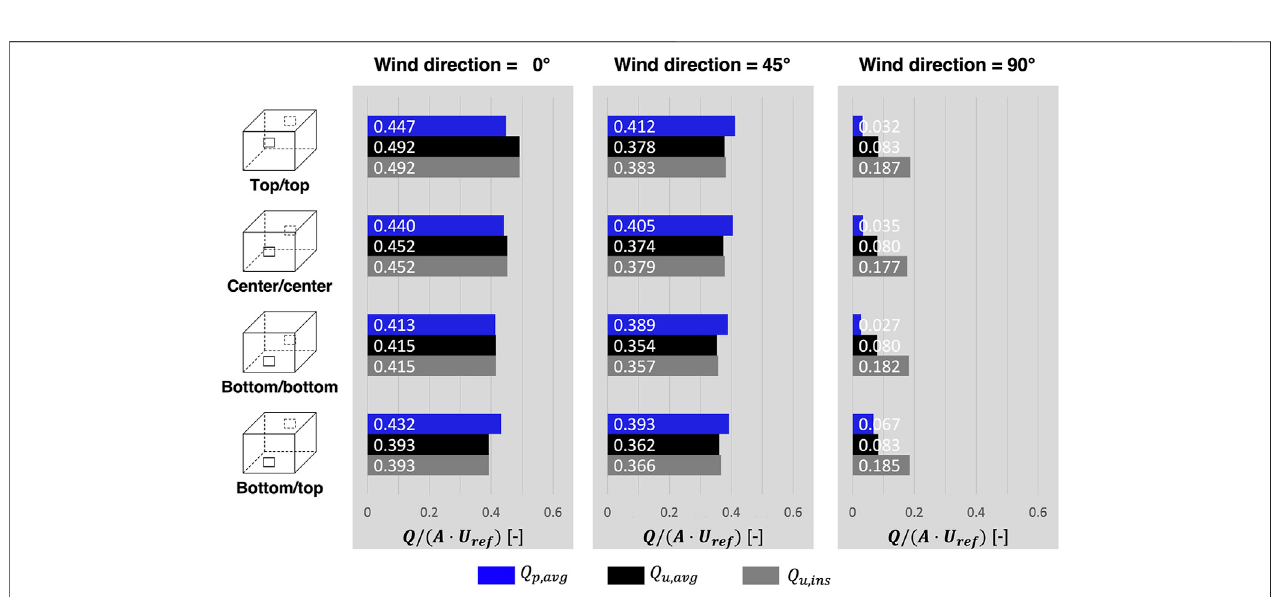
FIGURE 8 | Summary of non-dimensional ventilation rate under four different ventilation con fi gurations and three different wind directions.